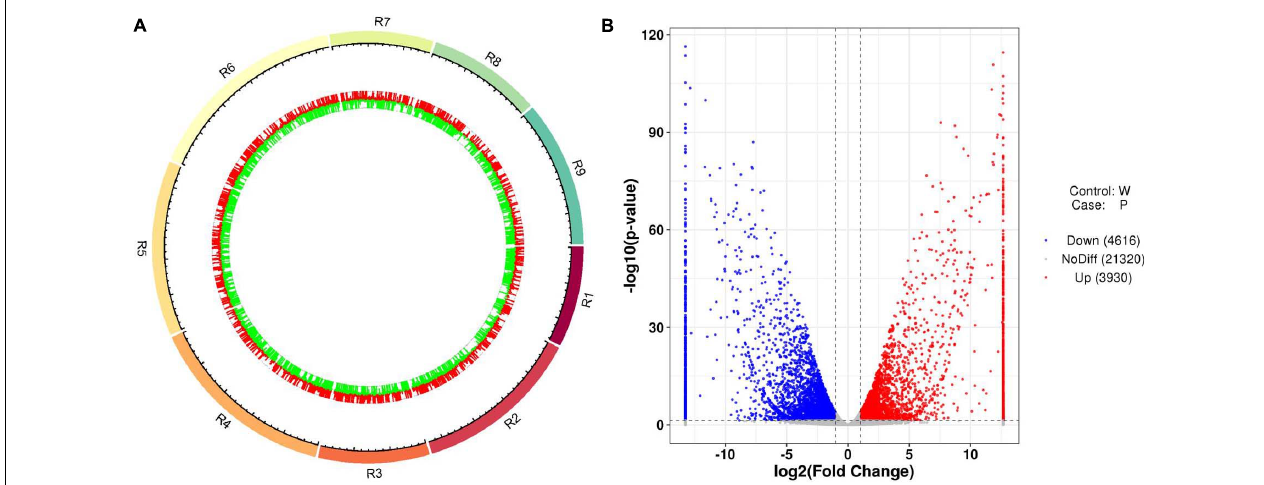
FIGURE 5 | Differentially expressed genes (DEGs) obtained between ZYR1 and HYR3 by the transcriptome analysis. (A) DEGs within the radish chromosomes. Red and green columns indicate the upregulated and downregulated genes in ZYR1 vs HYR3. (B) Volcano plot of the DEGs in ZYR1 vs HYR3. The red and blue dots indicated significantly upregulated or downregulated expression of genes in ZYR1 compared to HYR3.